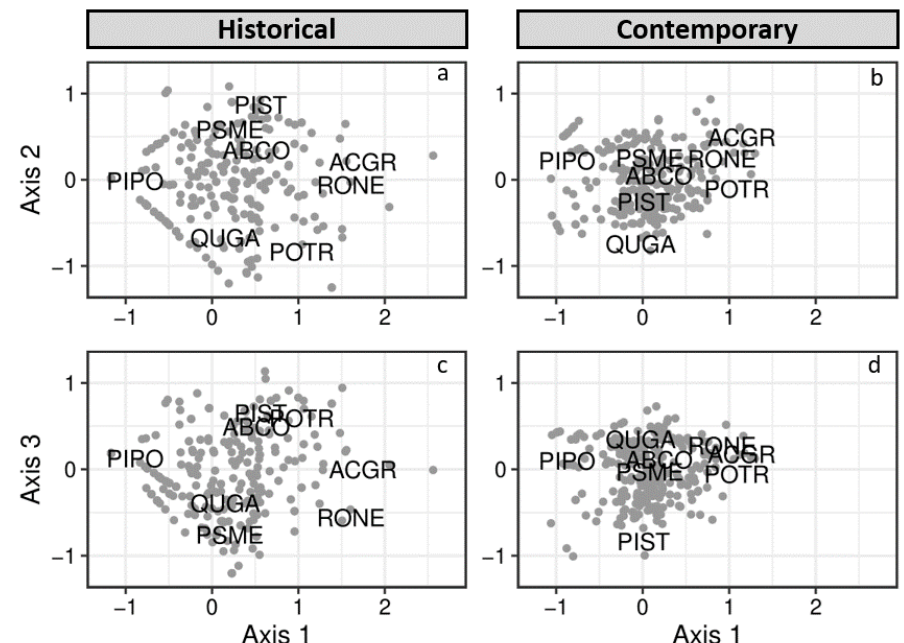
Figure A1. Ordinations of historical and contemporary forest community data. Points represent the composition of each site; the distance between points represents the similarity between the composition of each site; points that are close together are similar; points that are far apart are dissimilar. The three-axis ordination space is displayed as Axis 1 by Axis 2 ( a , b ), and Axis 1 by Axis 3 ( c , d ). Four letter species codes indicate the species scores within the ordination space: ABCO (white fir; Abies concolor ), ACGR (bigtooth maple; Acer grandidentatum ), PIPO (ponderosa pine; Pinus ponderosa ), PIST (southwestern white pine; Pinus strobiformis ), POTR (quaking aspen; Populus tremuloides ), PSME (Douglas-fir; Pseudotsuga menziesii ), QUGA (Gambel oak; Quercus gambelii ), and RONE (New Mexico locust; Robinia neomexicana).